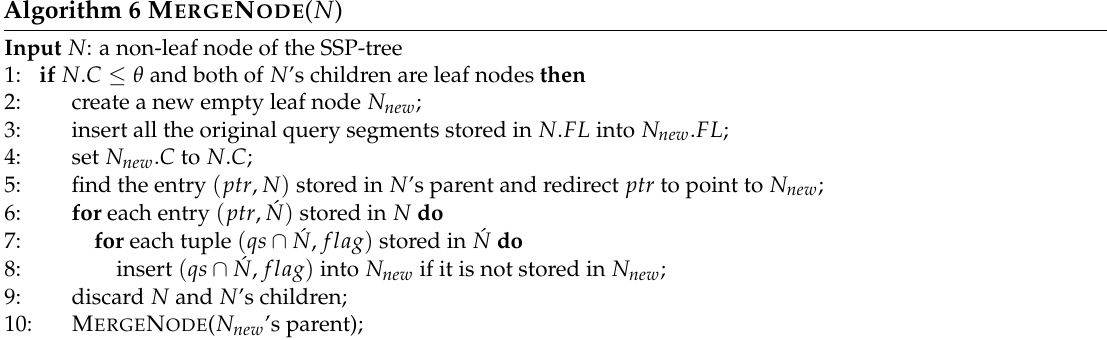
Algorithm 6 is the pseudocode of M ERGE N ODE . Given a non-leaf node N , M ERGE N ODE